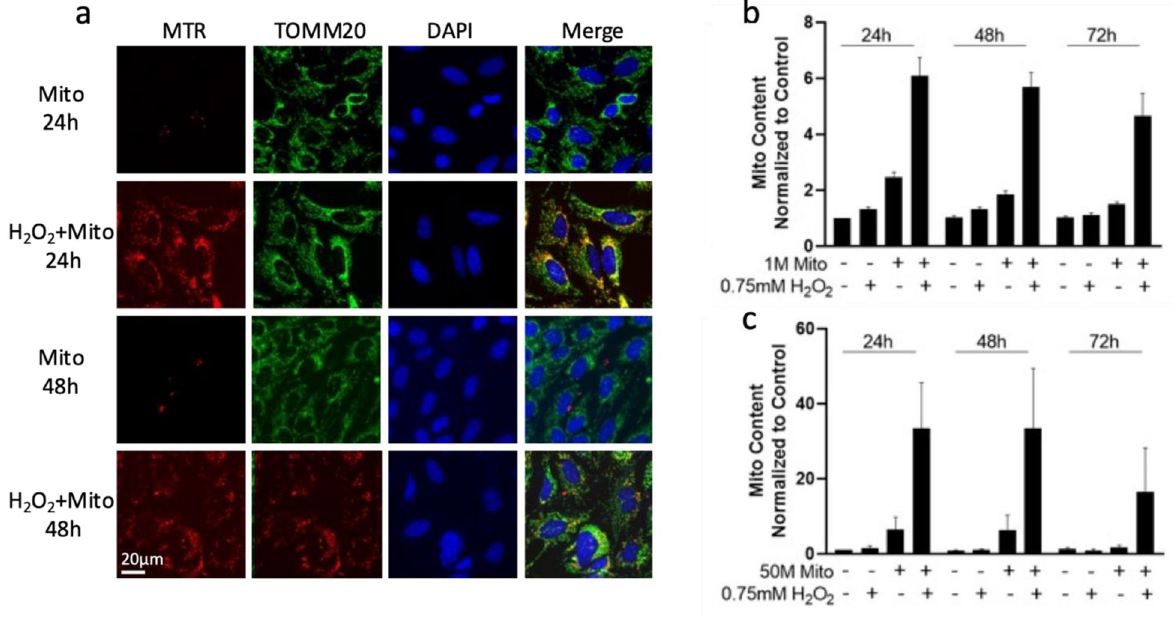
Figure 5. Oxidative stress enhances the survival of the transplanted mitochondria in retinal ganglion precursor-like cells. 661W cells were treated with 0.75 mM H 2 O 2 for 1 hour and then transplanted with mitochondria isolated from mouse liver. ( a ) Immunofluorescence staining shows exogenous mitochondria (MTR, red) uptake by 661W cells, stained for TOMM20 (endogenous mitochondria marker, green) and for the nuclear marker DAPI (blue) at the indicated time points. ( b , c ) Quantitative bar graph of flow cytometry ( b ) and qPCR ( c ) analysis of transplanted mitochondrial survival. Both graphs show a significant increase in mitochondrial content in 661W cells following stress compared to transplanted cells without stress throughout the 72 hours. n =